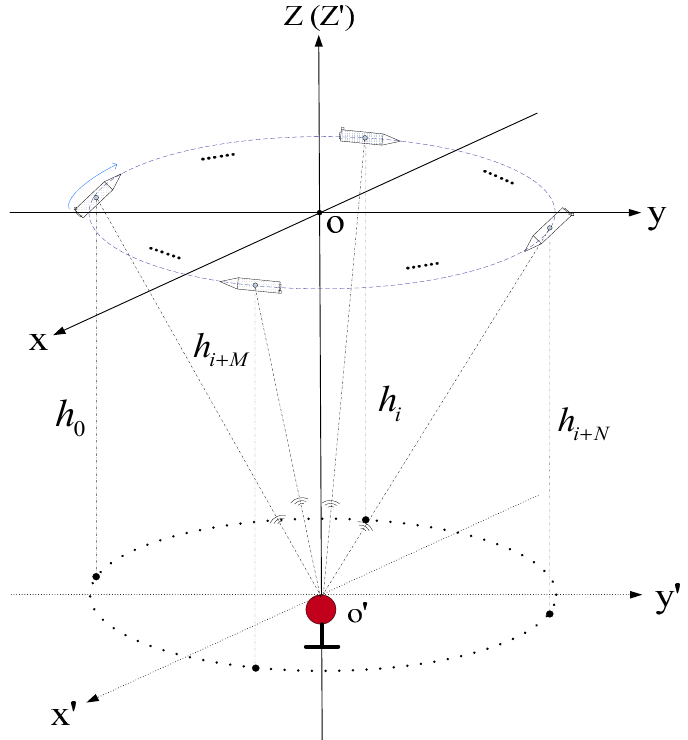
Figure 11. The sailing schematic diagram of the mother ship based on the rotating array and reusing elements method.